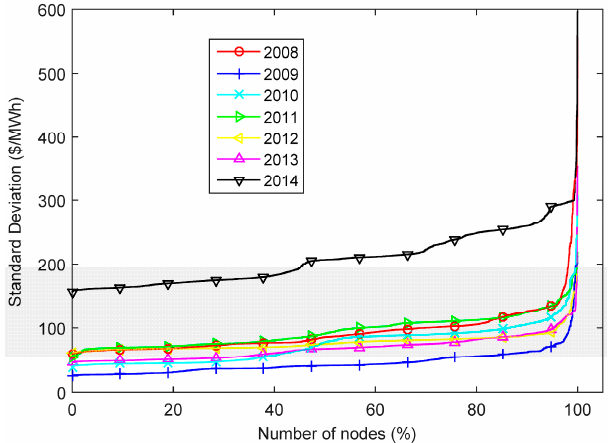
Figure 6. Average of the 10 highest daily standard deviation of real-time prices in PJM, encompassing 7395 nodes. The values are independently sorted by year.